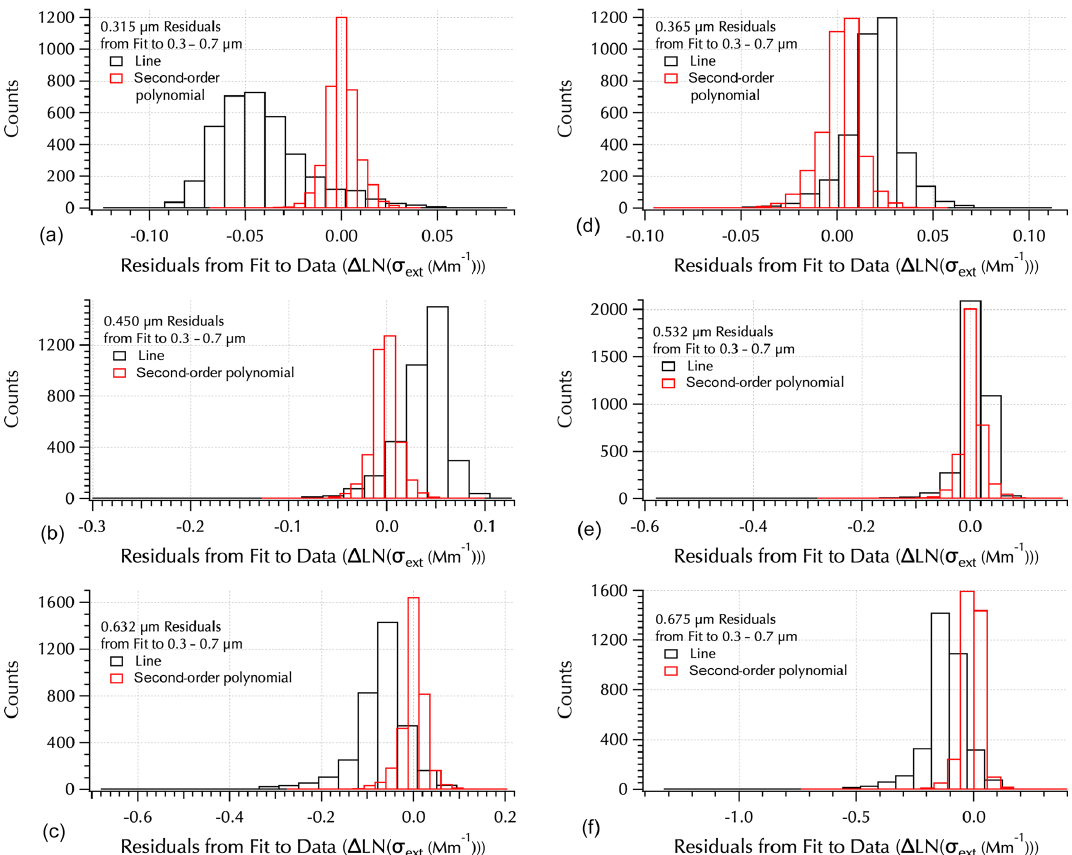
Figure 8. Comparison of residuals (the difference between the data and mathematical function fit to that data) from a line fit (black) and second-order polynomial fit (red) to the measured LN( σ ext ( Mm − 1 ) ) spectra over the 0.3–0.7µm range for six wavelengths: 0.315 (a) , 0.365 (d) , 0.45 (b) , 0.532 (e) , 0.632 (c) , and 0.675µm (f)